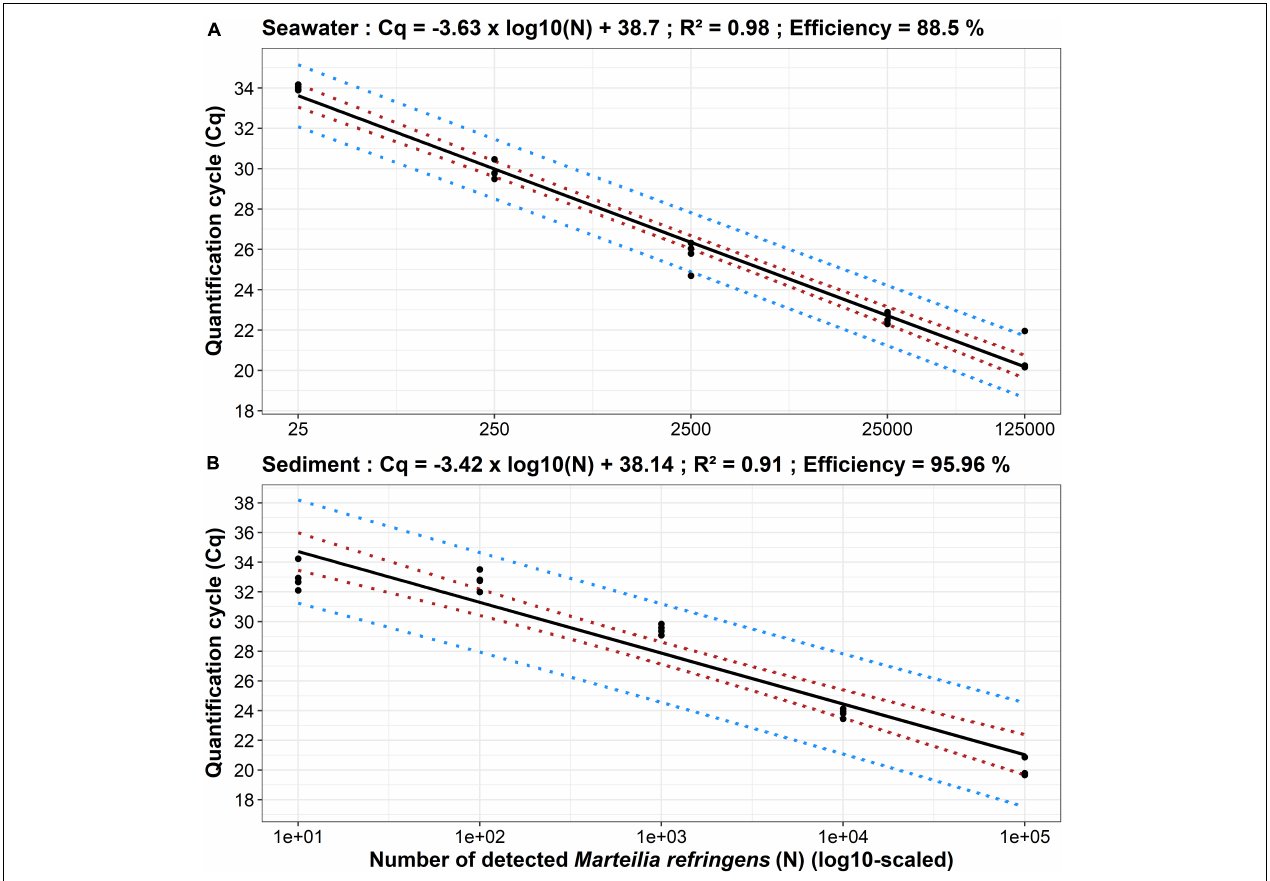
FIGURE 1 | Standard curves established from seawater (A) and sediment (B) real-time PCR analyses of Marteilia refringens dilution series. Dots represent experimental data, solid lines represent linear regression, and dotted coloured lines represent 95% confidence (red) and 95% prediction (blue) intervals. For each parasite amount, n = 4 except for 125,000 parasites (seawater) and 100,000 parasites (sediment) where n =